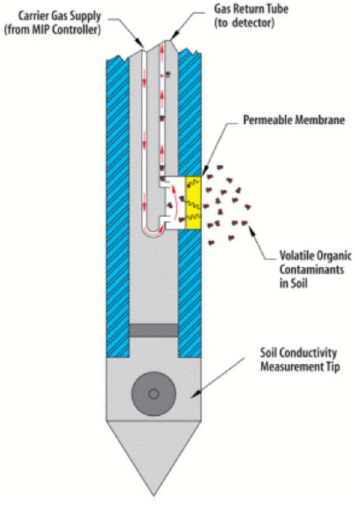
Figure 2. A schematic view of an MIP modified from